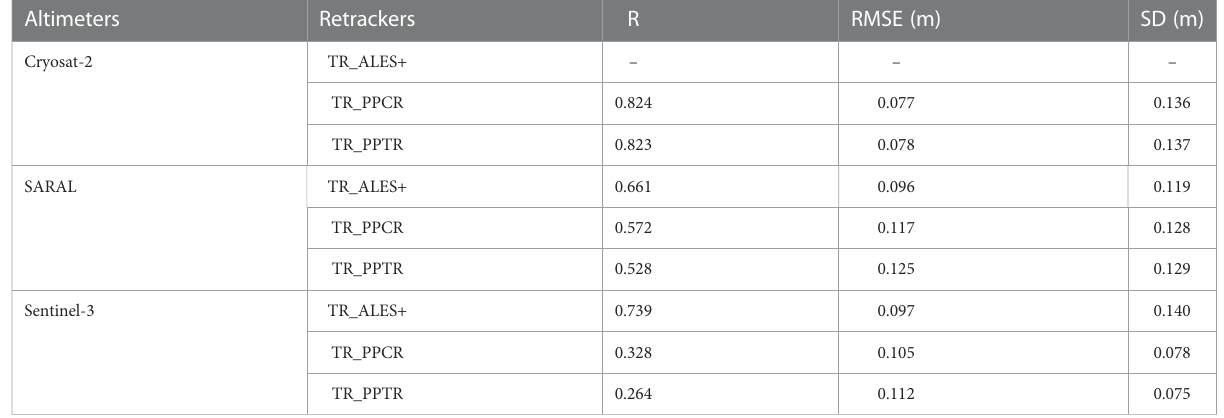
TABLE 5 Comparison of estimation accuracy of coastal water level based on three retracking